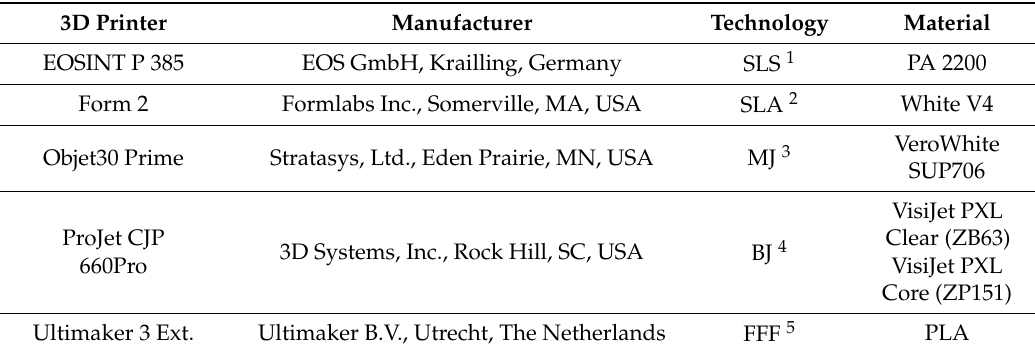
Table 1. Three-dimensional (3D) printers, manufacturers, technology, and material